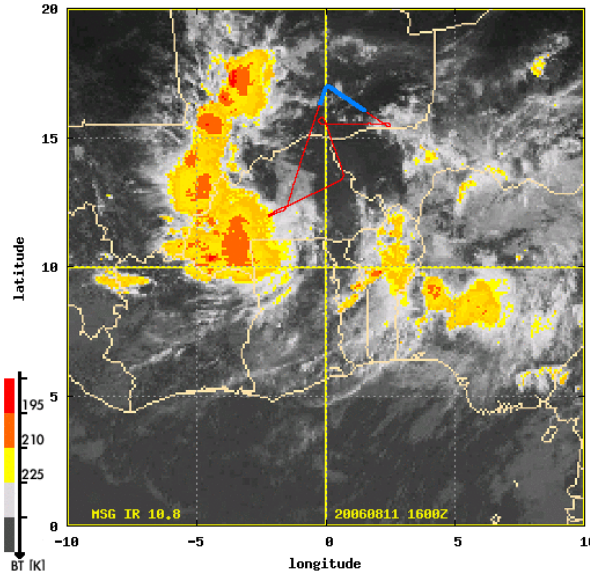
Fig. 7. MSG satellite image of the MCS on 11 August 2006 with the flight track of the M-55 Geophysica as indicated in blue/red.